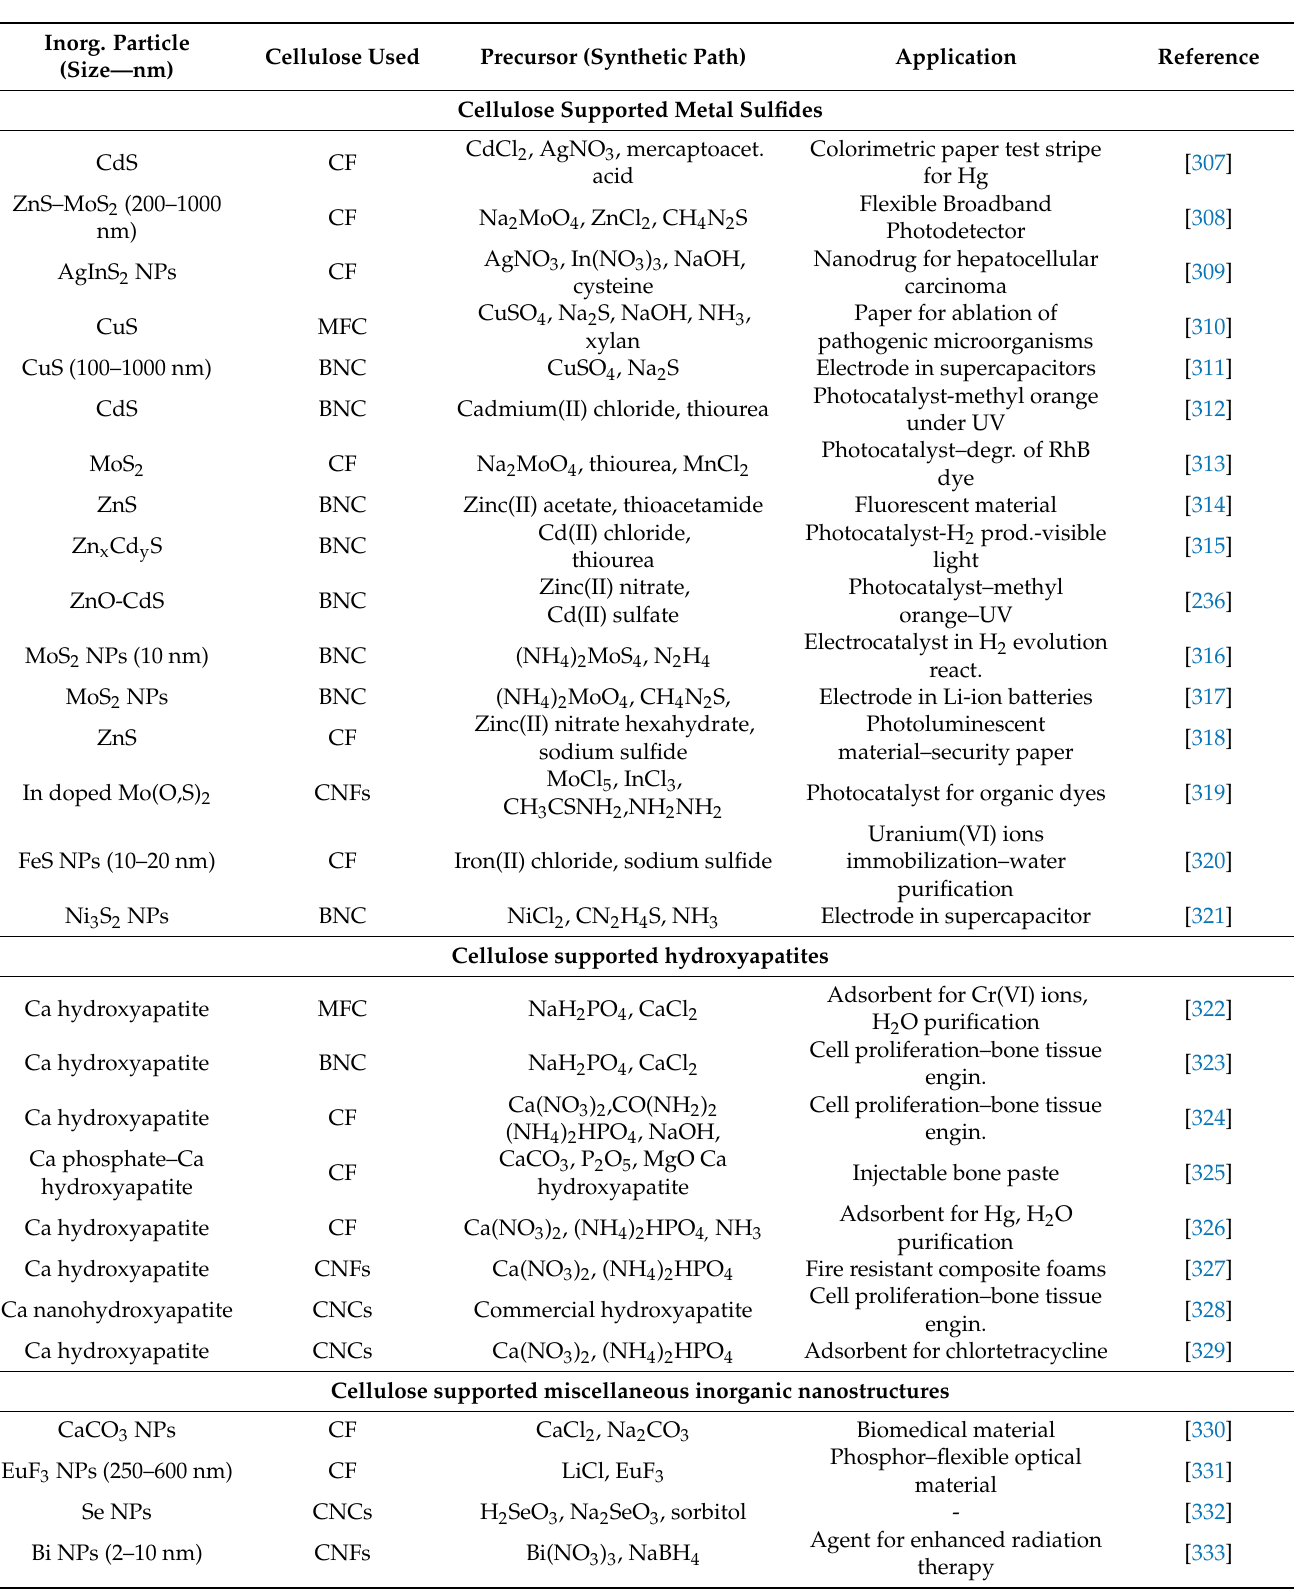
Table 5. The list of publications on cellulose supported metal sulfide, hydroxyapatite, and other inorganic nanostructures. The list is organized from large cellulose structures (CF and RC) via the microstructured celluloses (MCC and MFC) to nanostructured celluloses (BNC and CNCs). Inorg.